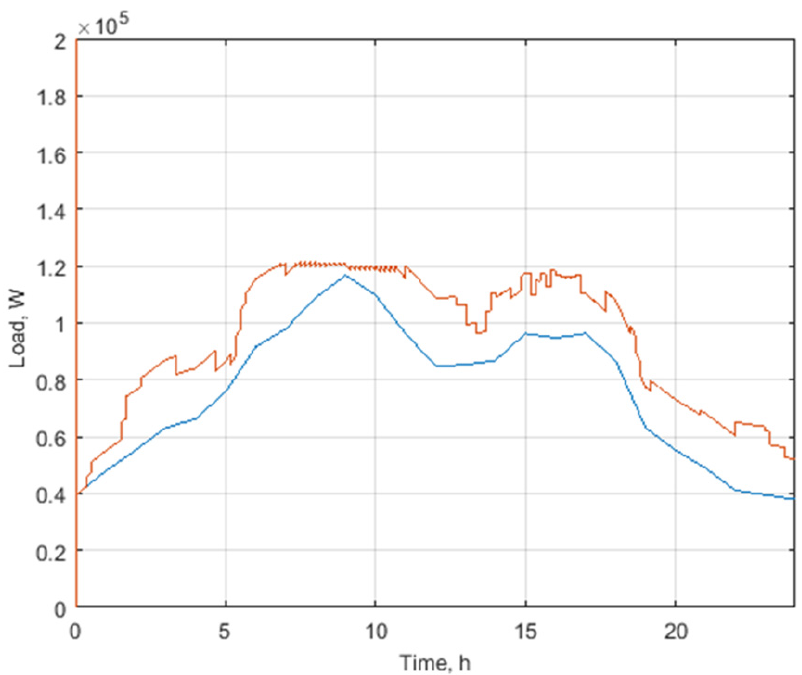
Figure 14. Power consumption over twenty-four hours based on charging according to the proposed situational EV charging algorithm based on CWI accounting. (Brown—general demand; Blue—CLN loading).